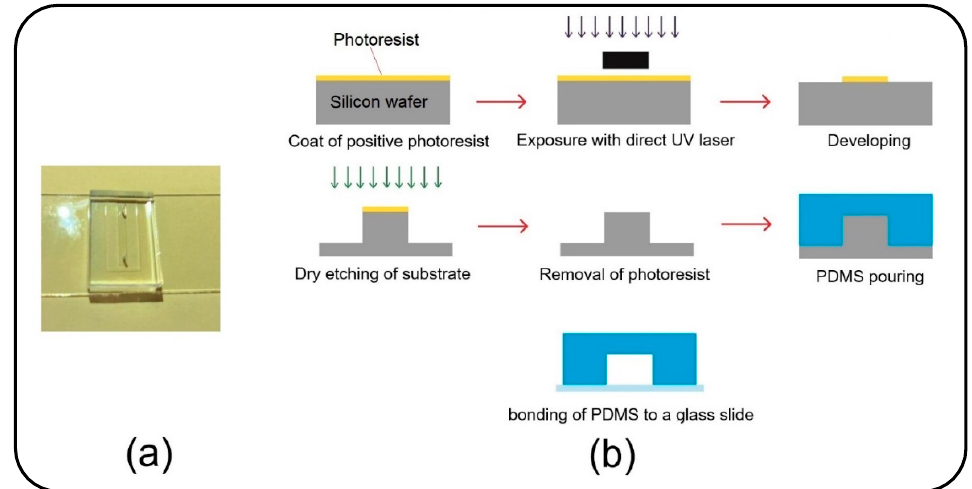
Figure 4. ( a ) Microfluidic device, which is bonded to a glass slide and contains a channel with one inlet and one outlet; ( b ) Schematic diagram of the fabrication process of the microfluidic device.